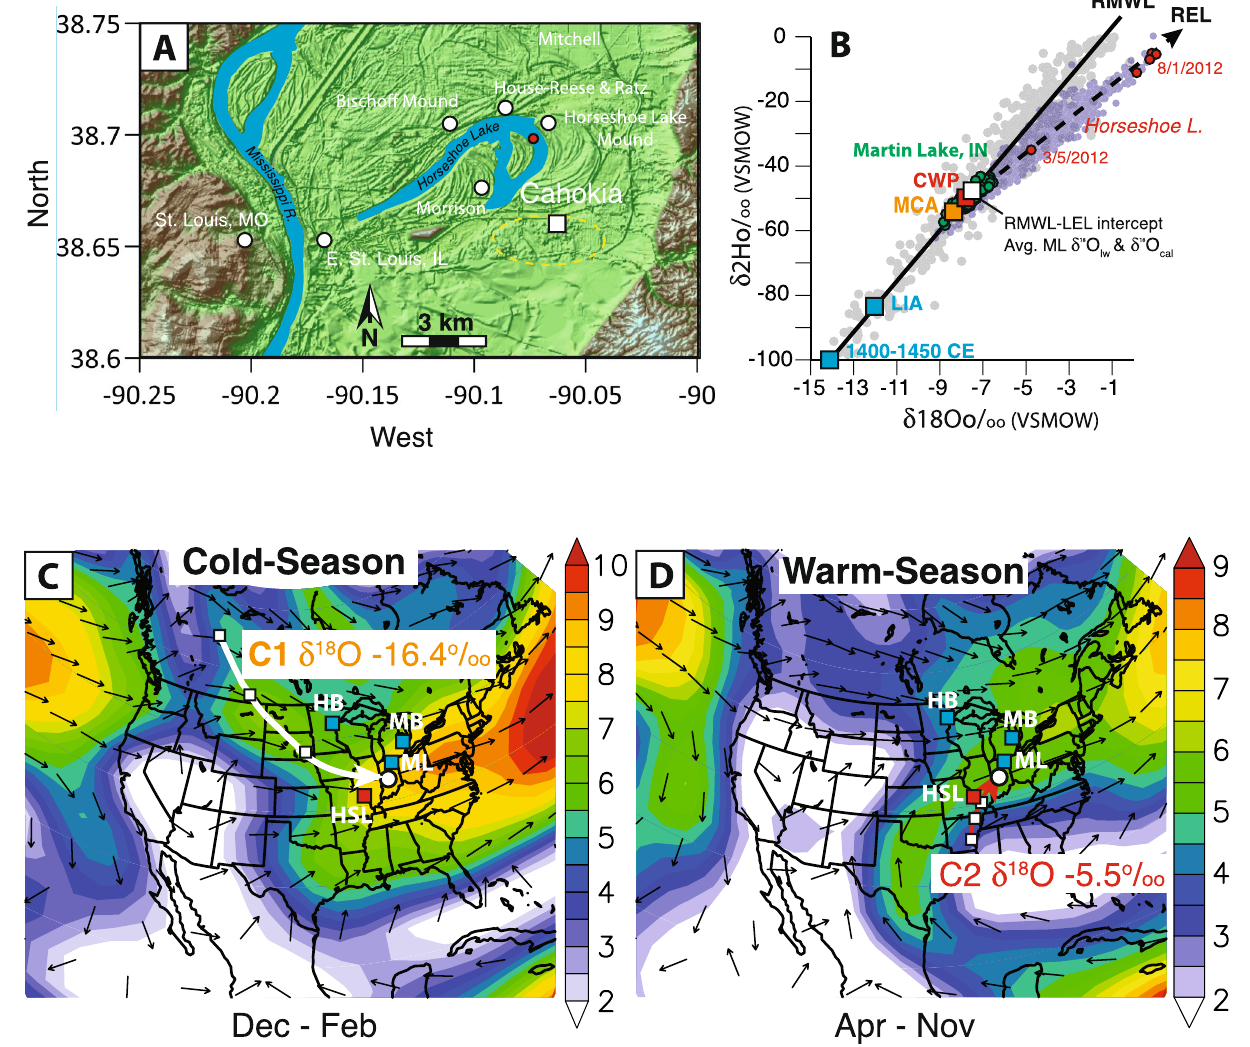
Figure 1. ( A ) Map of the American Bottom portion of the Mississippi River floodplain showing Horseshoe Lake’s position relative to prominent Mississippian urban centers (white circles), the largest of which was Cahokia (yellow dashed circle). Monks Mound, the largest earthwork at Cahokia, is indicated with a white square. The location from which the sediment core was collected is indicated with a red circle. ( B ) Hydrogen and oxygen isotope results for Indianapolis, IN, precipitation events (gray circles), Martin Lake, IN (green circles), Midwest lakes (light blue circles), and Horseshoe Lake (red circles). The white box indicates the intersection between the REL and RMWL that defines regional annual average δ 18 O precip . Average isotopic compositions of precipitation during past climate events, including the Medieval Climate Anomaly pluvial (orange square), Little Ice Age average and most severe drought from 1350 to 1450 CE (blue squares), and current warm period (red square) are also shown. δ 18 O values were calculated from δ 18 O cal using an average temperature of 18 °C. Composite mean maps of ( C ) cold-season (December–March) and ( D ) warm-season (April–November) 850 hPa vector winds between 1949 and 2015 CE are from the NCEP-NCAR reanalysis database 13 . Arrows are wind directions with colored shading indicating velocity (m/s). Also plotted are mean back trajectories for cluster 1 (thick white line in A ) and cluster 2 (thick red line in B ) of the event-based Indianapolis, IN, precipitation samples. White squares are spaced at 24-h intervals. White circles indicate the starting point from which back trajectories were calculated. The mean back trajectories are in agreement with their respective seasonal atmospheric circulation patterns since 1949 CE. Paleoclimate records discussed in the text are shown with blue squares. Horseshoe Lake is indicated with a red square. Images provided by the NOAA/ ESRL Physical Sciences Division, Boulder Colorado (http:// www. esrl. noaa. gov/